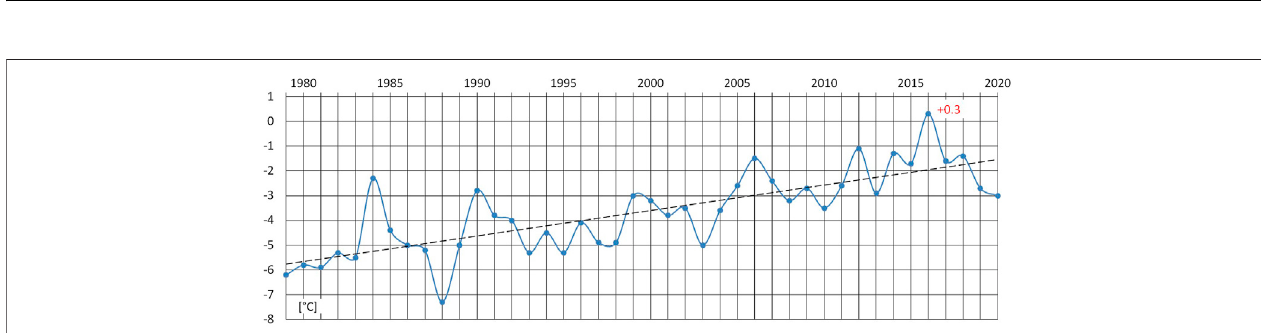
FIGURE 6 | Mean annual air temperature measured at the Polish Polar Station in Hornsund. Data based on: Marsz and Styszy ń ska (2013), Meteorological Bulletin (2009 – 2020). The graph also shows the trend line (black dashed line).